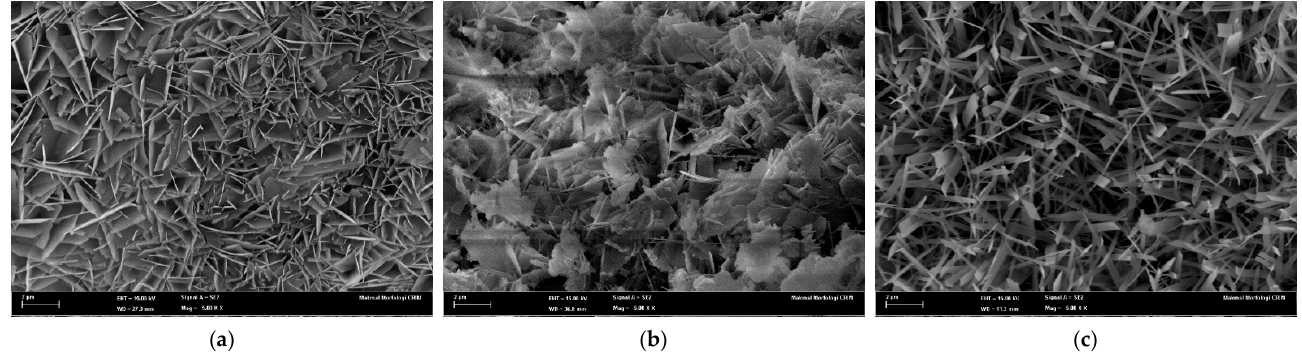
Figure 10. Comparison of the crystalline structure of specimens at 2 µm for ( a ) AAC-R30, ( b ) AAC- R50, and ( c ) traditional AAC.